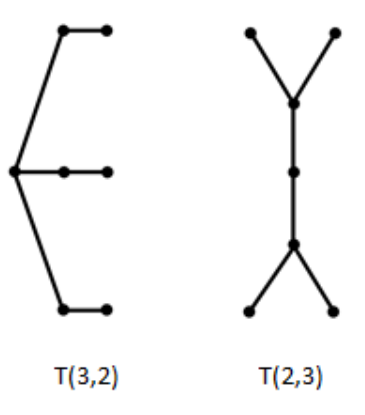
Figure 1: Seven-vertex trees having equal spectral radius